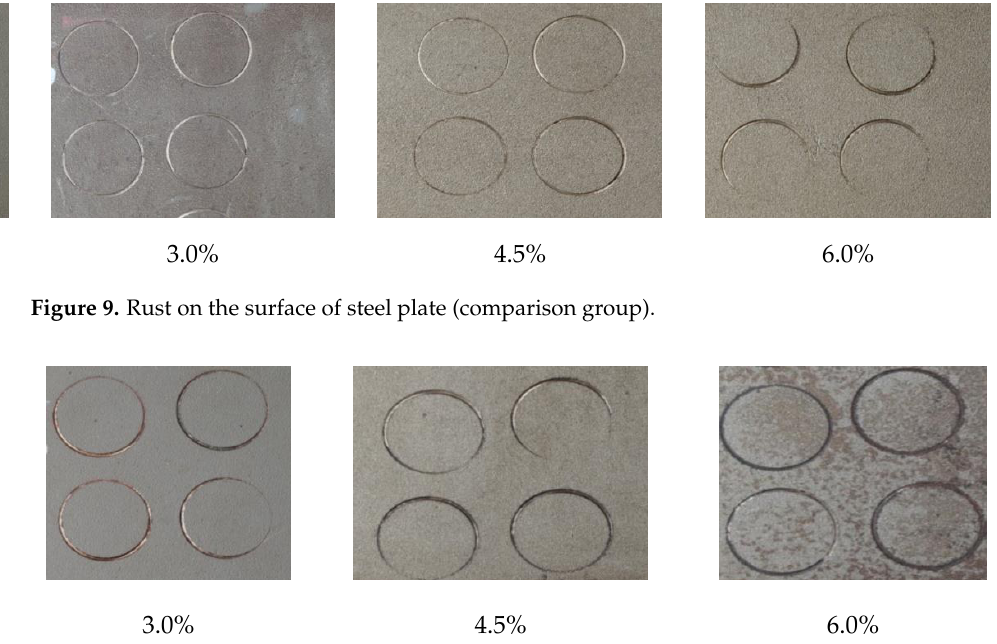
Figure 10. Rust condition on the surface of steel plate (high temperature loading and salt spray erosion group).